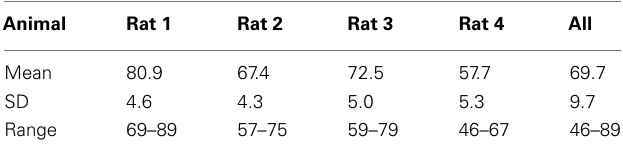
FIGURE 7 | Generalization curves of mixtures of the trained stimuli. (A) Binary mixtures. * P < 0.05, ** P < 0.01, *** P < 0.001 (MANOVA on stimuli). (B) Tertiary and quaternary mixtures. * P < 0.05, ** P < 0.01, *** P < 0.001 (MANOVA on tertiary stimuli). Asterisks at y = 0 indicate the elements of the mixture. Pink horizontal lines are drawn to indicate theoretical